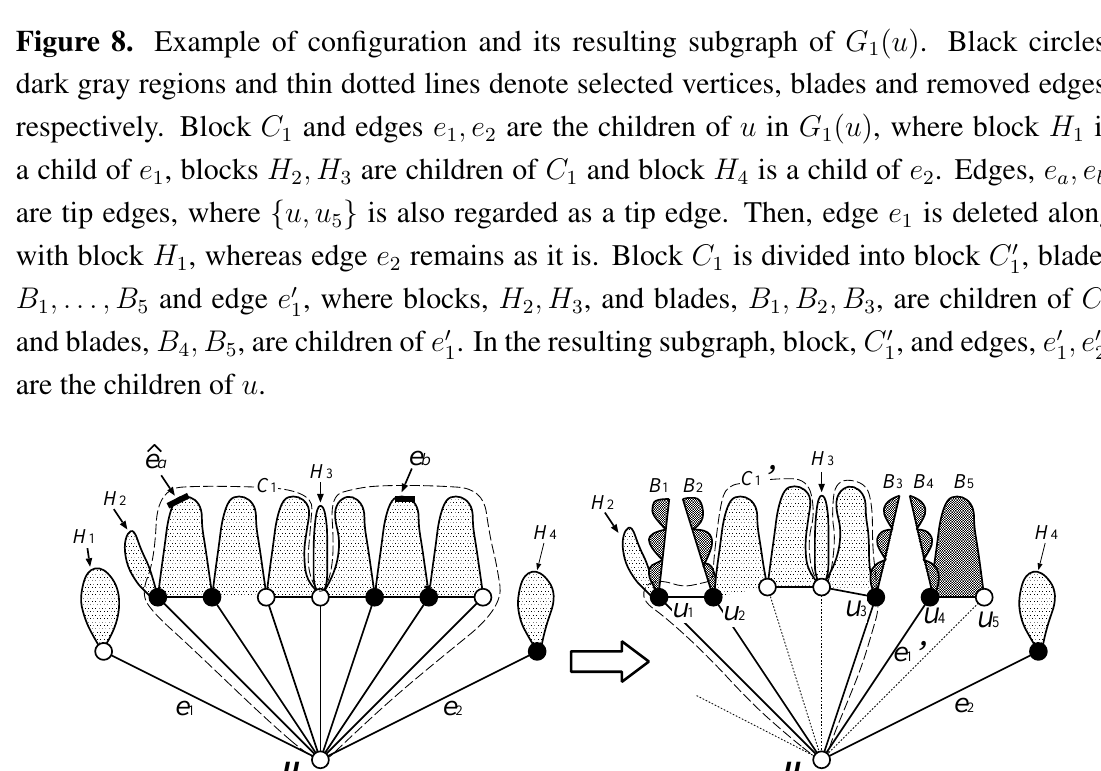
Figure 8. Example of configuration and its resulting subgraph of G dark gray regions and thin dotted lines denote selected vertices, blades and removed edges, ; e respectively. Block C and edges e are the children of u in G 1 1 2 ; H a child of e , blocks H are children of C and block H 1 2 3 1